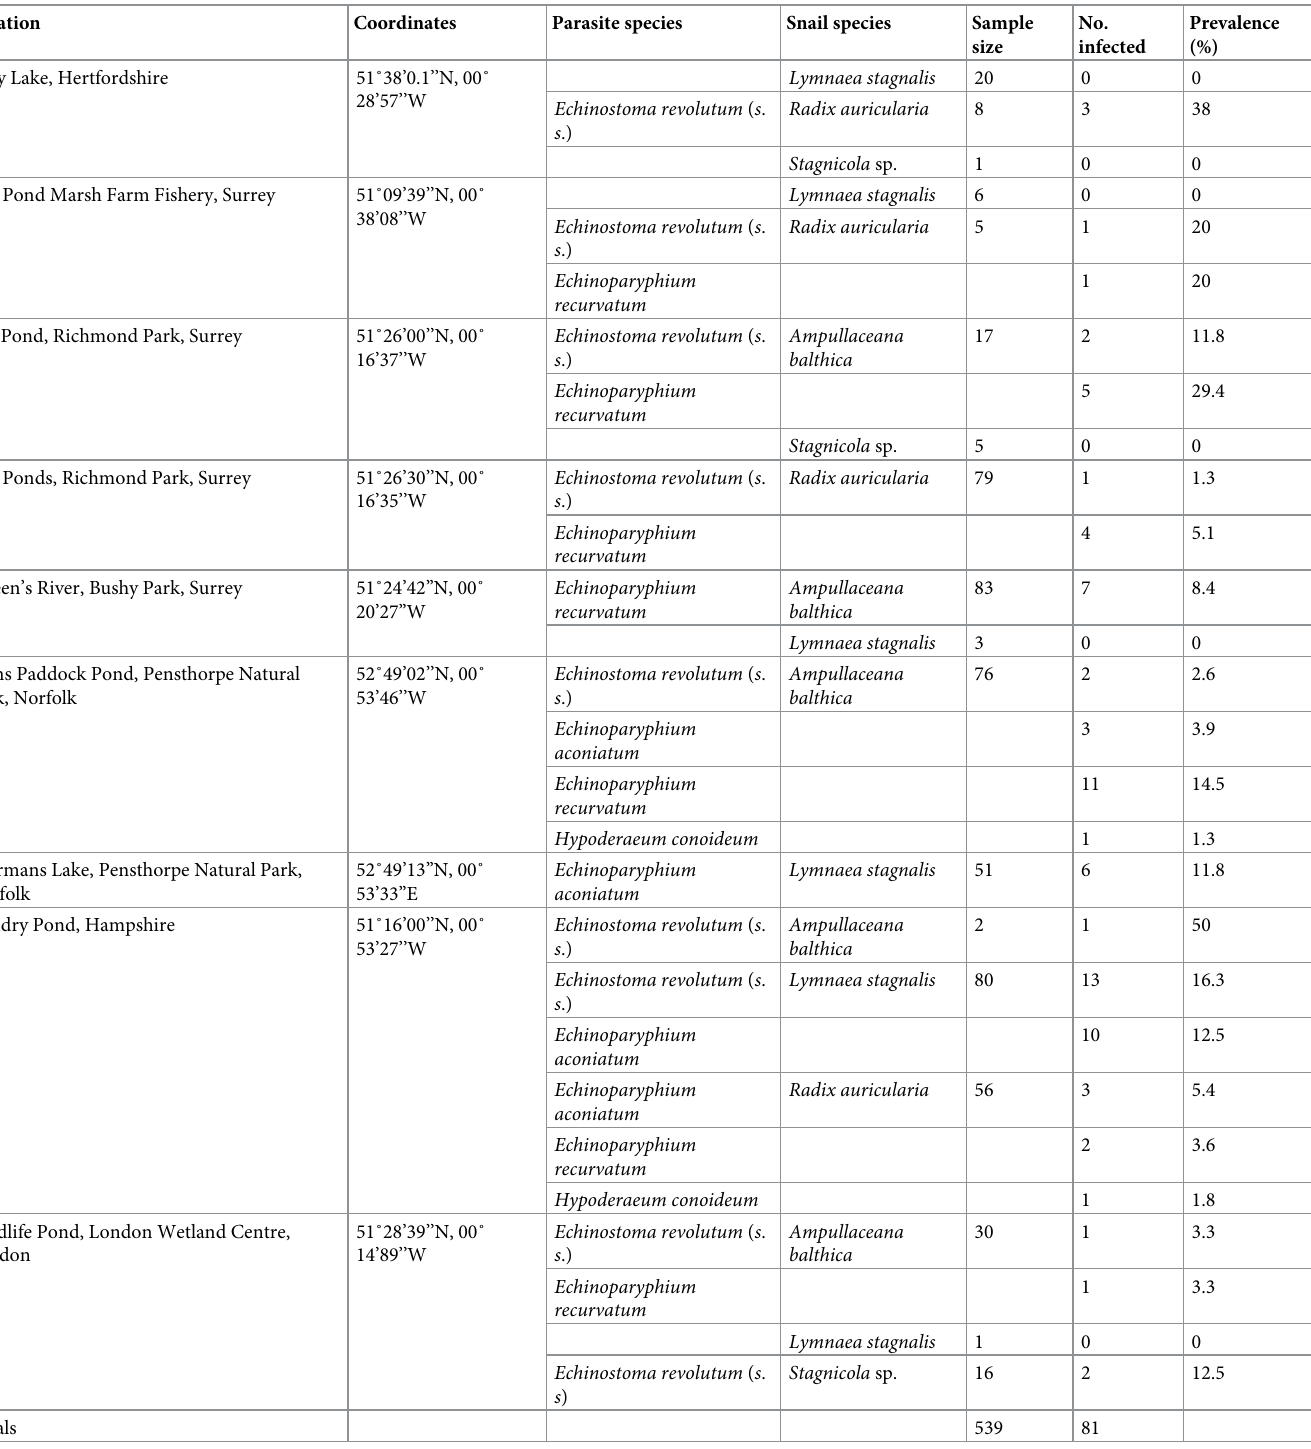
Table 1. Summary data on snail species from echinostomatid infected freshwater sites in